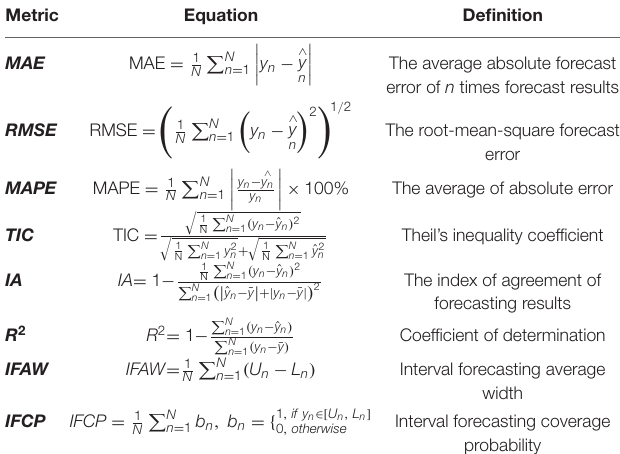
TABLE 2 | Eight evaluation